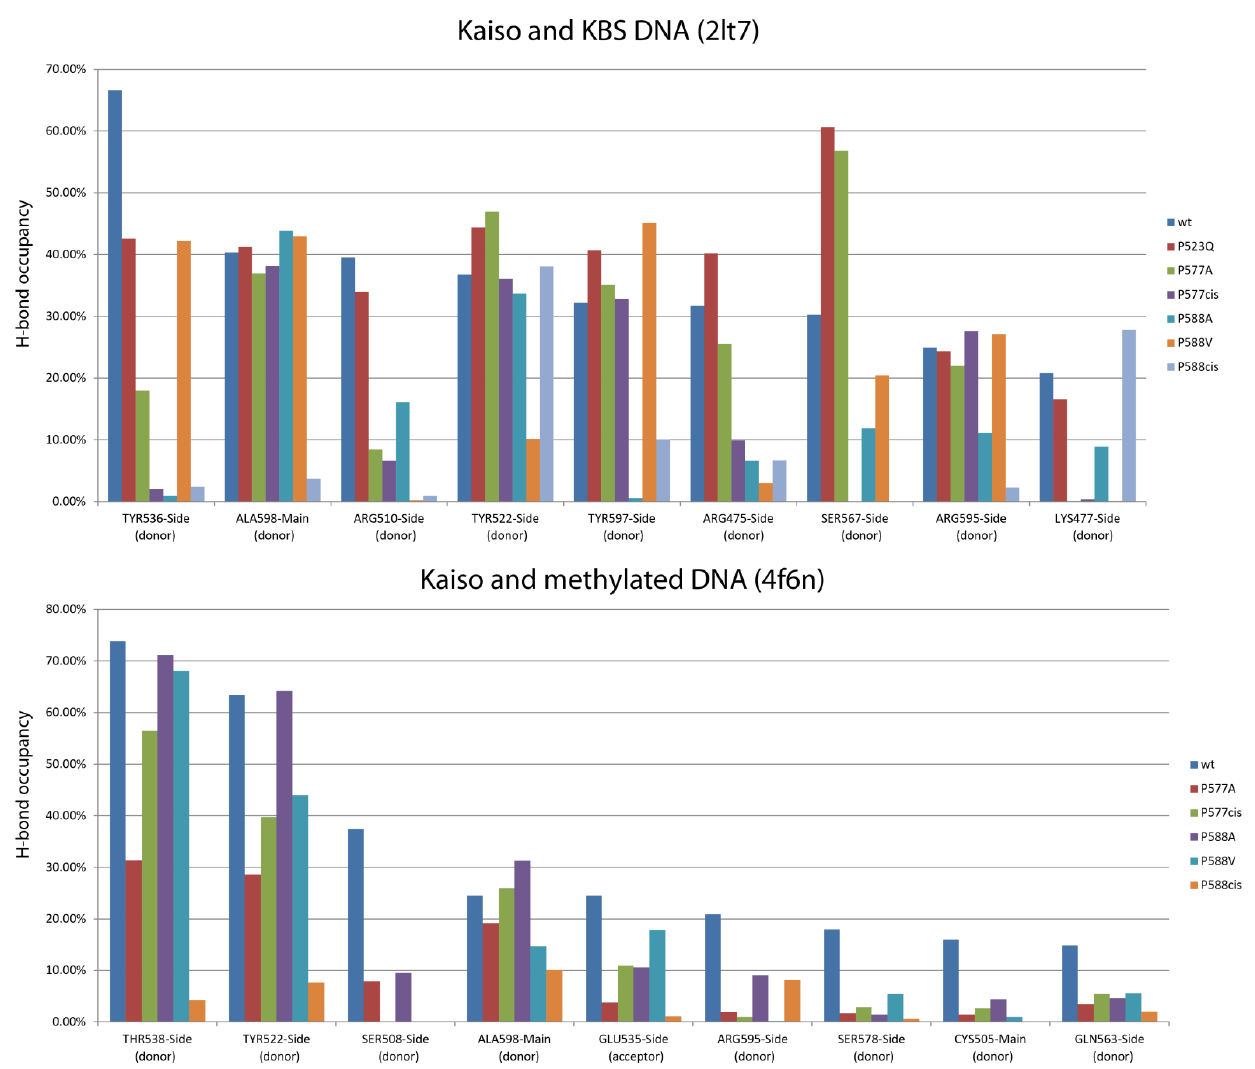
Figure 3. The plots of the presence of protein–DNA hydrogen bonds that weakened more than 2-fold (compared to wild-type protein) along the last 90 ns of 100 ns molecular dynamics trajectories of Kaiso complexes with KBS or CG-methylated DNA. Only bonds with over 15% presence in wild-type protein are shown. Complete data are shown in Supplementary Table S2 (KBS) and 3 (methylated DNA). Several affected H-bonds (R595, Y597, and A598) make contact with the DNA minor groove and are formed by residues located in the C-terminal extension of the zinc-finger domain that is directly affected by the isomerization, while few bonds are formed by residues lying within the second zinc-finger domain (Y536 and T538), S567, which also forms hydrogen bonds, is in the third zinc-finger motif. Notably, most of these bonds are base-specific interactions; thus, their loss may result in a decrease in binding specificity (Figure 2b and 3, Supplementary Table S2 and S3). However, most of the bonds located in the first and second zinc fingers involved in core sequence recognition [15] remain unchanged.